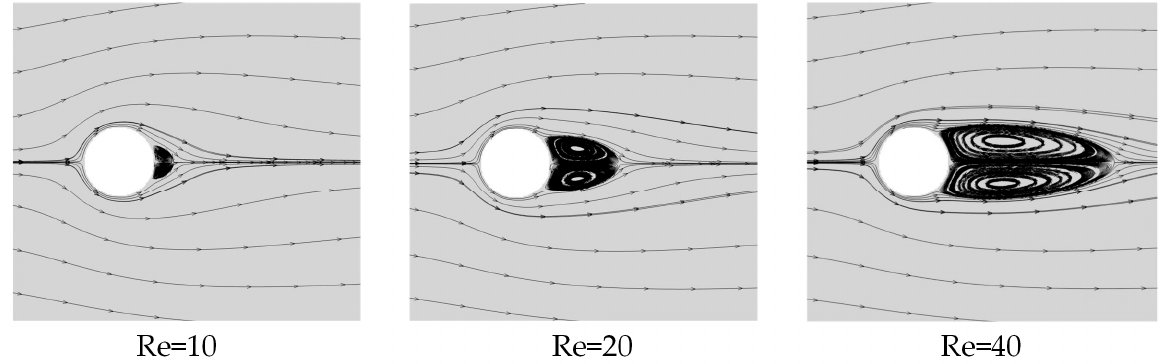
Figure 15. Streamline of the flow around circular cylinder at different Reynolds numbers.